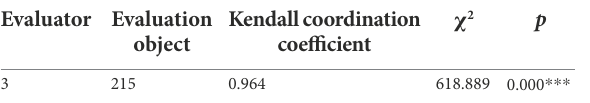
TABLE 5 Kendall W coordination coefficient analysis.